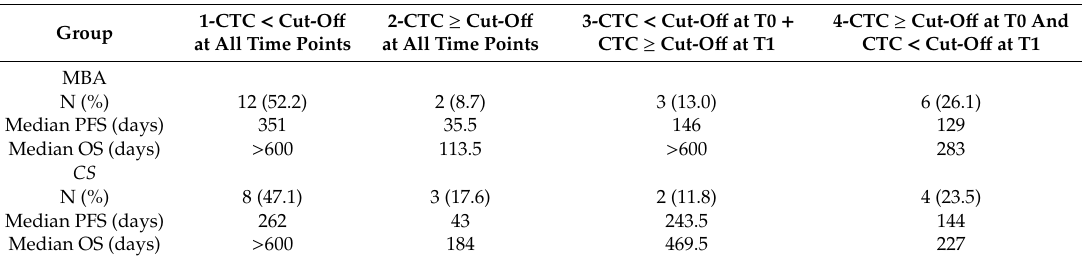
Figure 6. Progression-free survival (PFS) and overall survival (OS) of mBC patients stratified by the level of CTC before and after therapy. Patients were stratified into four groups: Group 1 (green curve), patients with a CTC count < cut-o ff both at T0 and T1; Group 2 (violet curve), patients with a CTC count ≥ cut-o ff both at T0 and T1; Group 3 (blue curve), patients who presented a CTC count below and equal and higher than the cut-o ff at T0 and at T1, respectively; and group 4 (yellow curve), patients with a change of CTC count from above to below the cut-o ff at T0 and T1, respectively. ( A ) Kaplan-Meier plots of changes in CTC level from baseline (T0) and the first follow-up (T1) to predict PFS with the metabolic-based assay (MBA) and ( B ) the CellSearch (CS). ( C ) Kaplan-Meier plots of changes in CTC level from baseline (T0) and the first follow-up (T1) to predict OS with the MBA and ( D ) the CS. Statistical analysis of PFS and OS between the 4 groups are reported in the embedded tables. Table 6. PFS and OS by the CTC status before and after therapy for the metabolism-based assay (MBA) and the CellSearch